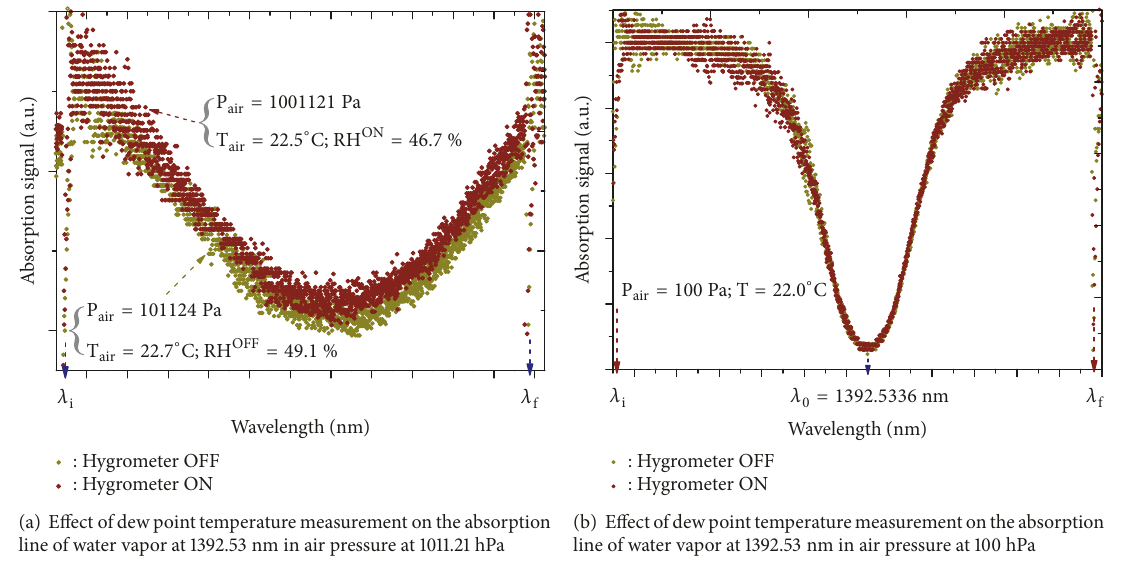
(b) Effectofdewpointtemperaturemeasurementontheabsorption line of water vapor at 1392.53 nm in air pressure at 100 hPa